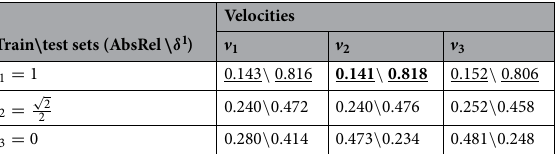
Table 8. Model performance in different ego-motion modes. The best result in each column is underlined and the optimal result is bolded.